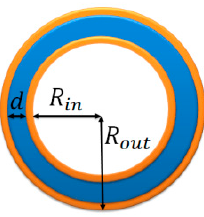
Figure 5. Schematic illustration of a typical vesicle, where R in is the inner radius, d is the wall thickness